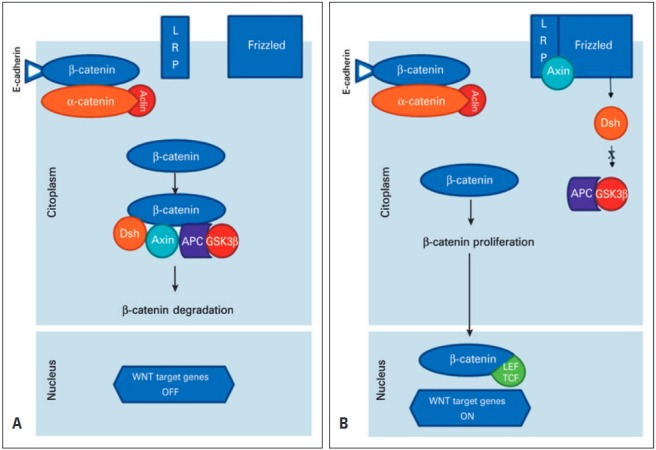
The Wnt/beta-catenin signaling pathway. (A) In the presence of the destroyer complex, beta-catenin is degraded via adenomatous polyposis coli/axin/glycogen synthase kinase 3β. (B) When the binding of beta-catenin with the complex by destroying not occurs, then the beta-catenin is not phosphorylated and this protein penetrates the cell nucleus. Inside the nucleus, the beta-catenin binds to the transcription factor target genes lymphoid enhancing factor/T-cell factor to promote carcinogenesis